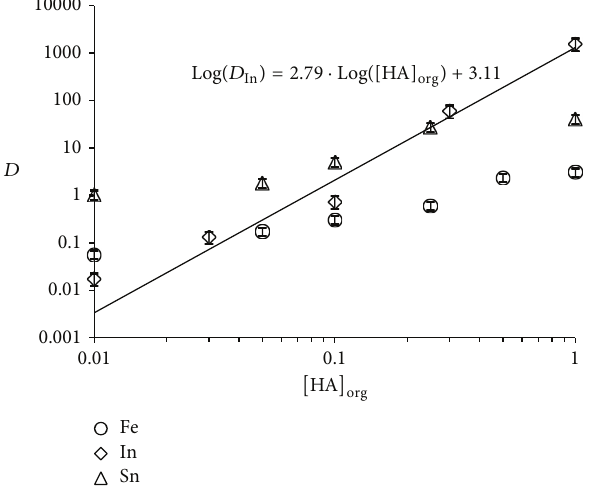
Figure 6: Effect of free D2EHPA concentration on the extraction of metals from 1M H 2 SO 4 at 293 ± 2K and 𝜃 = 1 .